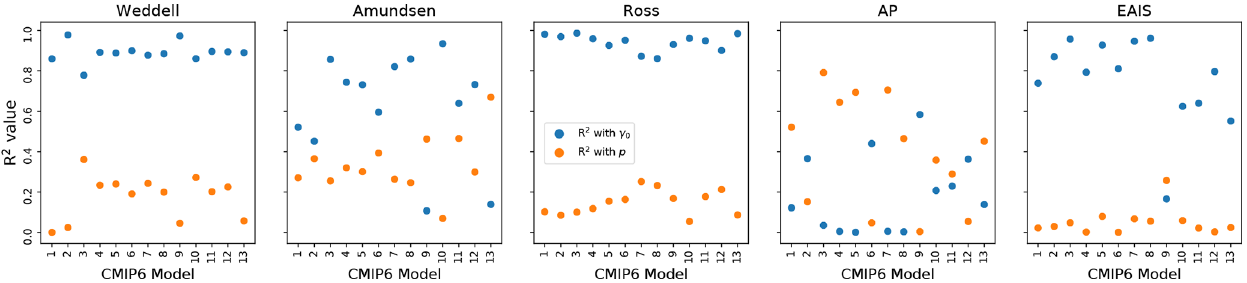
Figure 12. R 2 correlation values for fits between final (year 500) SLR and p (orange) and γ 0 (blue). Panels distinguish region. Each blue/orange regional pair represents one CMIP6 model. The correlations are generally higher with γ 0 than with p , particularly in the Weddell, Ross and EAIS regions. In the Amundsen and AP, the TF anomalies are generally weaker and the signal becomes less clear. The corresponding order of CMIP6 model from 1 to 13 is: BCC–CSM2–MR, CAMS–CSM1–0, CESM2, CNRM–CM6–1, CNRM–ESM2–1, CanESM5, EC– Earth3, EC–Earth3–Veg, GFDL–CM4, GFDL–ESM4, IPSL–CM6A–LR, MPI–ESM1–2–HR,